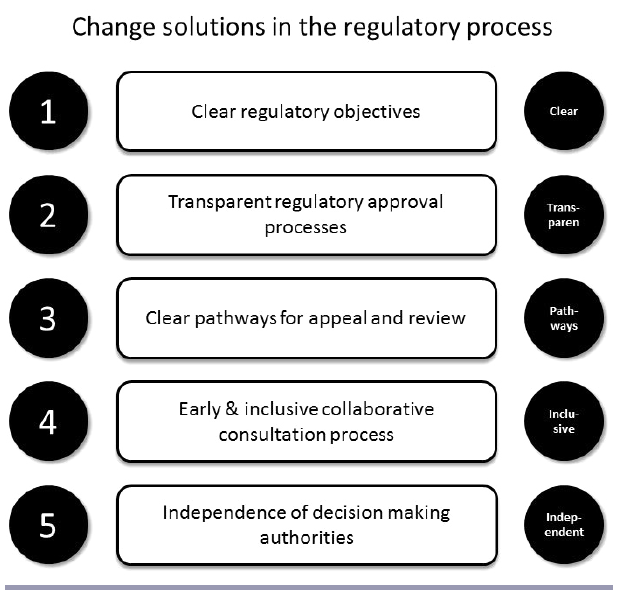
Fig. 2 . Conceptual model of the five solutions (and interactions between them) offered through reimagining the regulatory processes and how they will affect social licence (in the black box) by way of positive drivers of change (trust and legitimacy). Also shown are the external factors that influence trust and